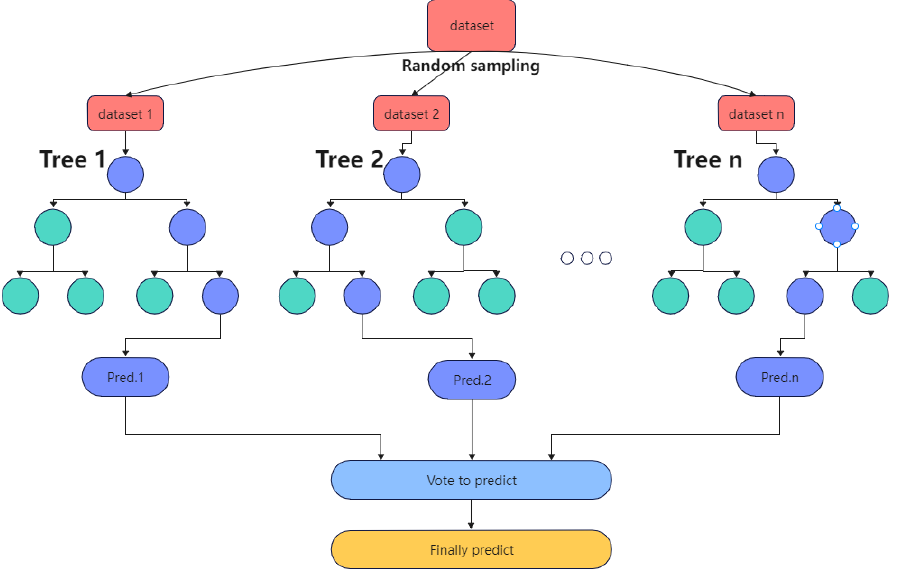
Figure 1. Diagram of random forest prediction